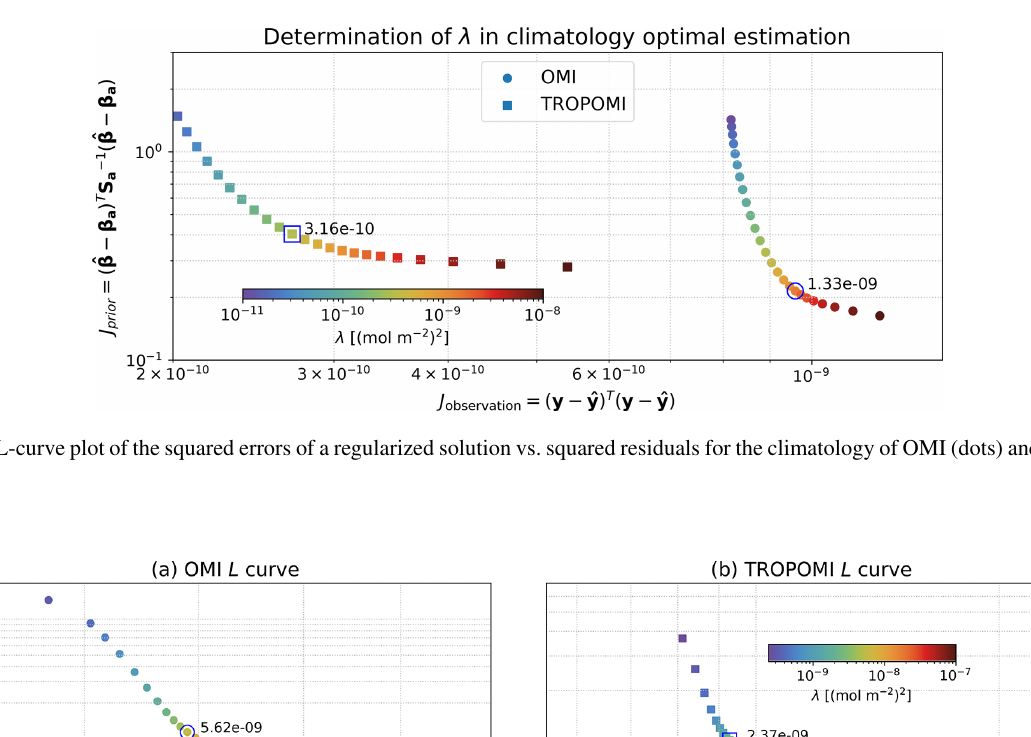
Atmos. Chem. Phys., 21, 13311–13332, 2021